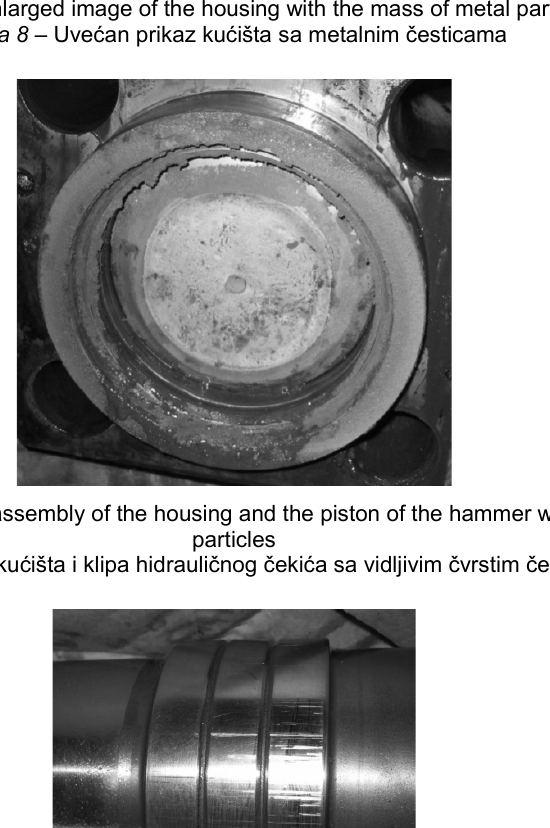
Figure 8 – Enlarged image of the housing with the mass of metal particles